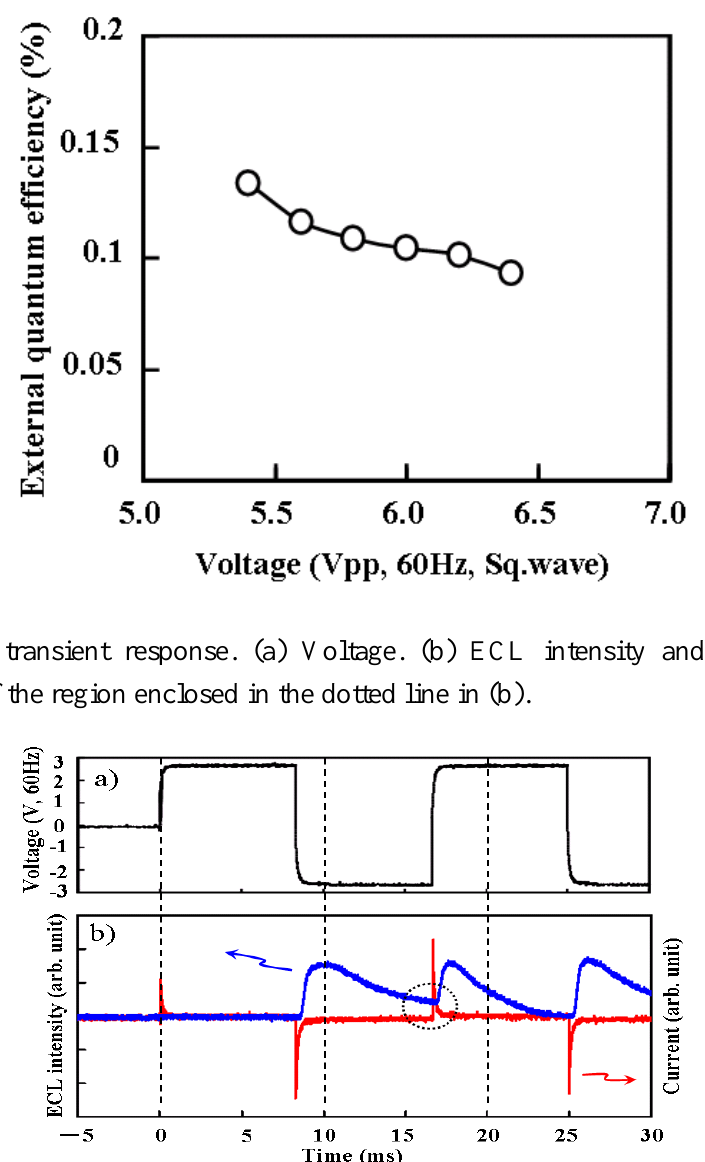
nanoparticles 2